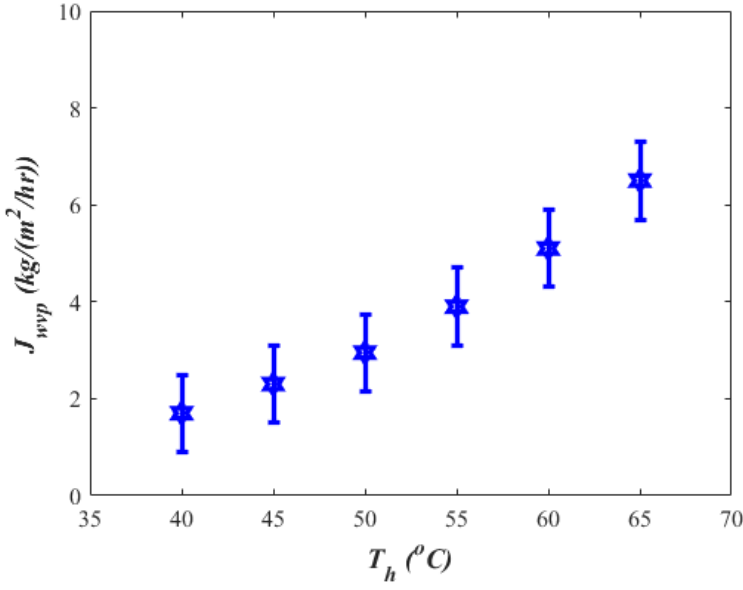
Figure 16. J wvp at different hot feed temperatures (T h ).